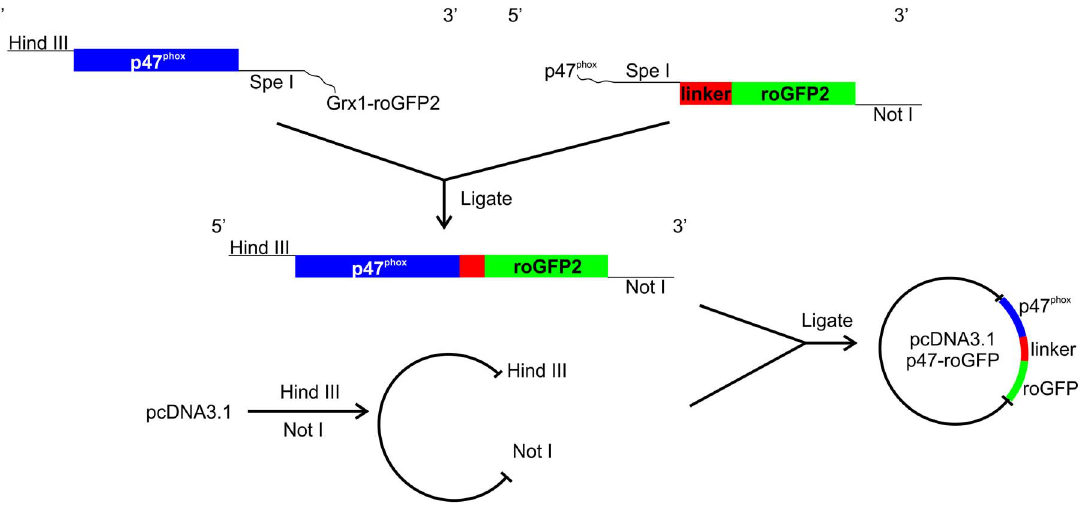
Figure 1. Construction of the Nox biosensor p47-roGFP. The coding sequences of human p47 phox and roGFP2, carrying a 30-amino-acid linker, were PCR amplified from pcDNA3.1-p47 phox and pLPCX-Grx1-roGFP2, respectively as described in Materials and Methods. The forward and reverse primers for the two reactions were designed to incorporate HindIII, SpeI and NotI restriction sites. Both PCR products were purified and ligated to form a linear p47 phox -linker-roGFP expression cassette, which was cloned into the pcDNA3.1 vector using HindIII and NotI restriction